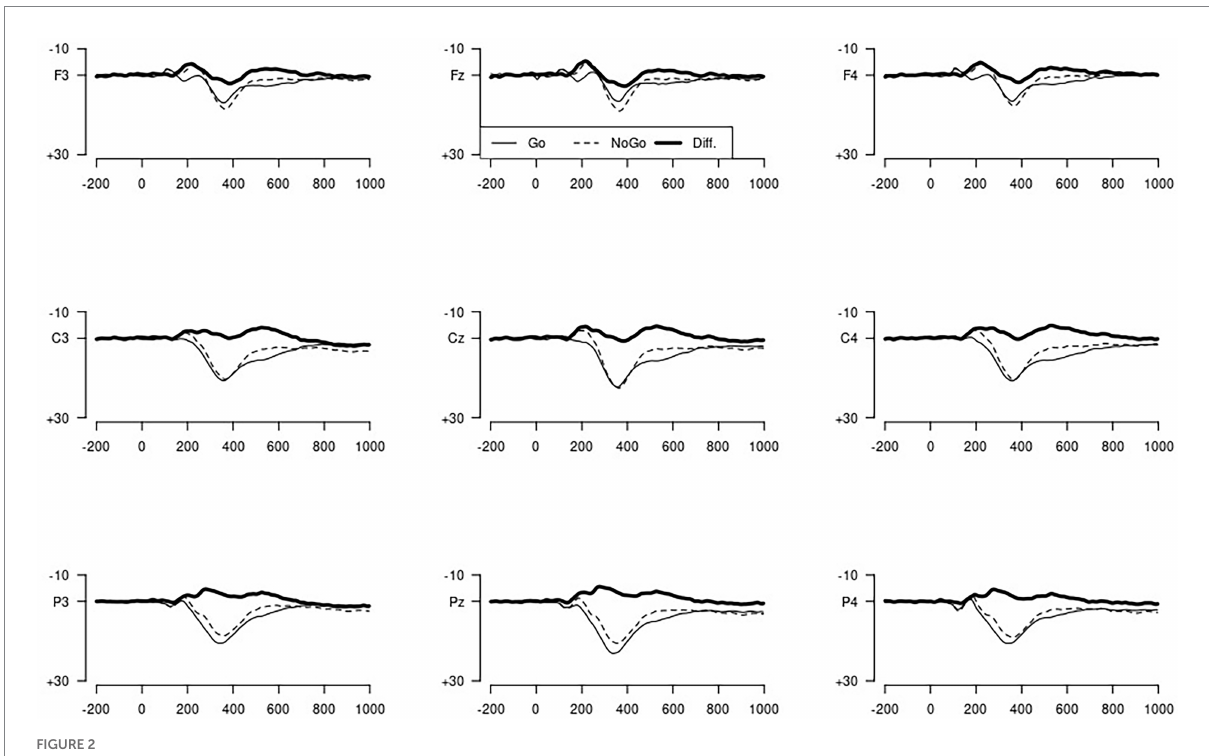
FIGURE 2 Overview of event-related potentials for Go and NoGo trials.